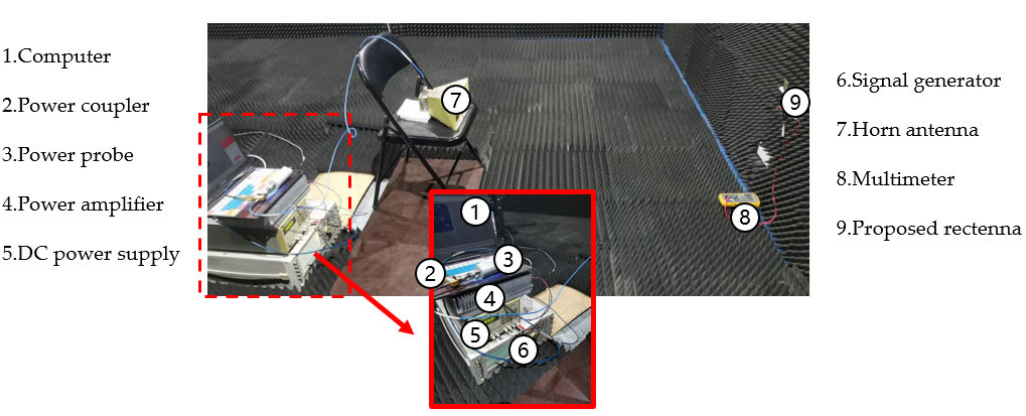
Figure 19. The conversion efficiency measurement setups of the proposed rectenna. Table 2. Measured results of the rectenna performance.